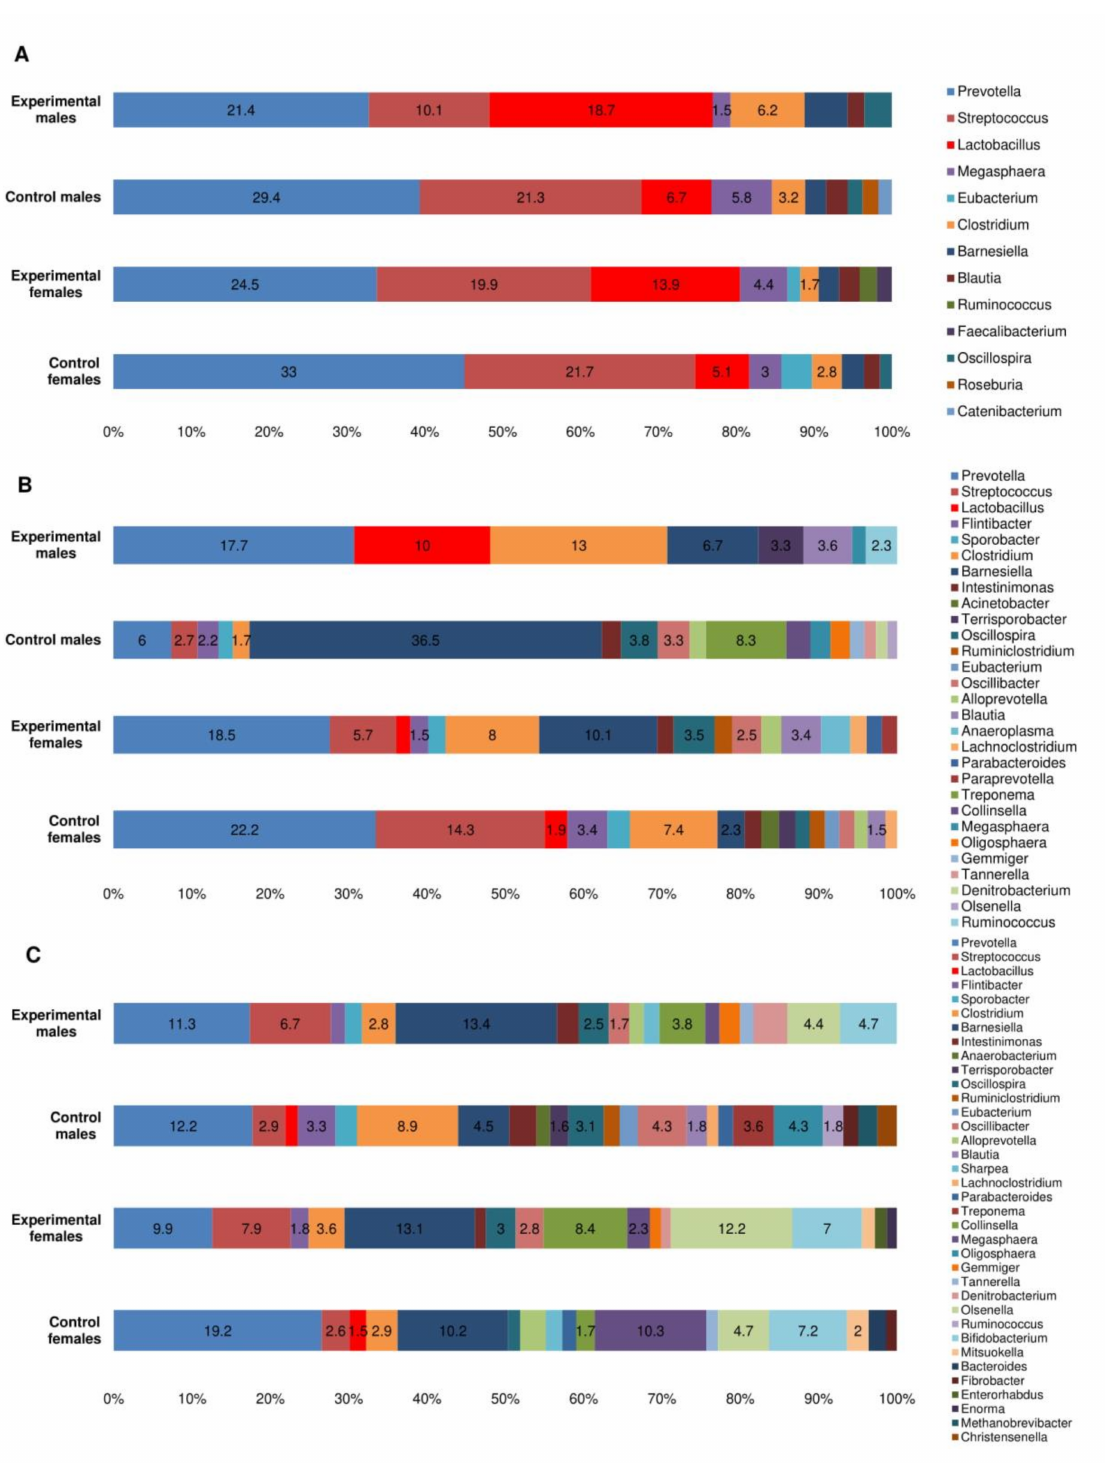
Figure 5. Bacterial genera in test animal and negative control group intestinal microbiota 7 days ( A ), 14 days ( B ) and 28 days ( C ) after supplementary feeding. Genera with prevalence rate of >1% are